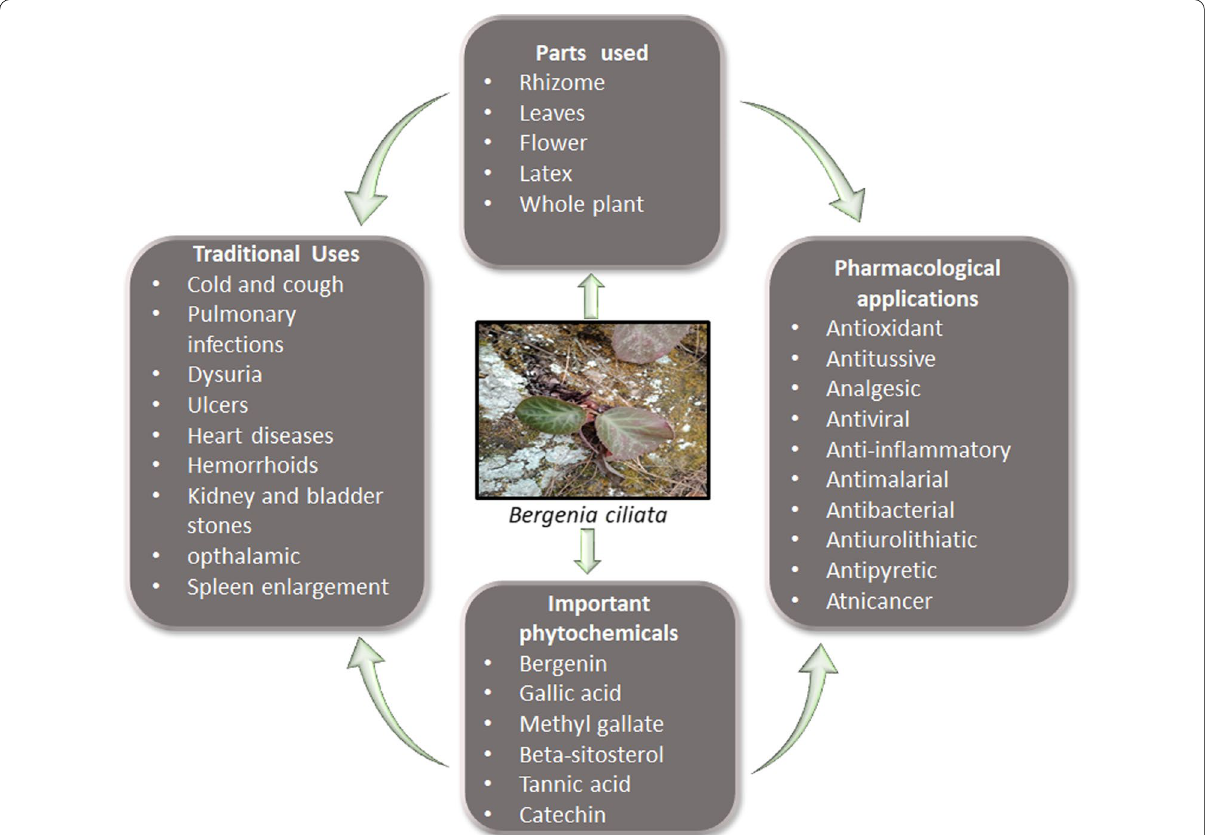
Fig. 1 Schematic representation of parts used, phytochemicals and applications of Bergenia ciliata against different